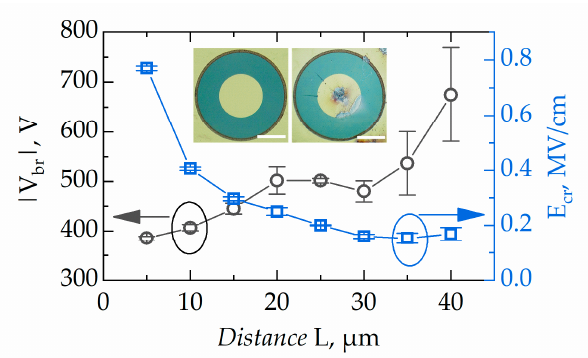
Figure 7. Breakdown voltage and critical electric field dependences on the distance between ohmic and Schottky contacts: error bars in the critical field data are depicted by the size of the symbols. Inset: images of L = 40 μ m SBD before and after breakdown (scale bar is 50 μ m).